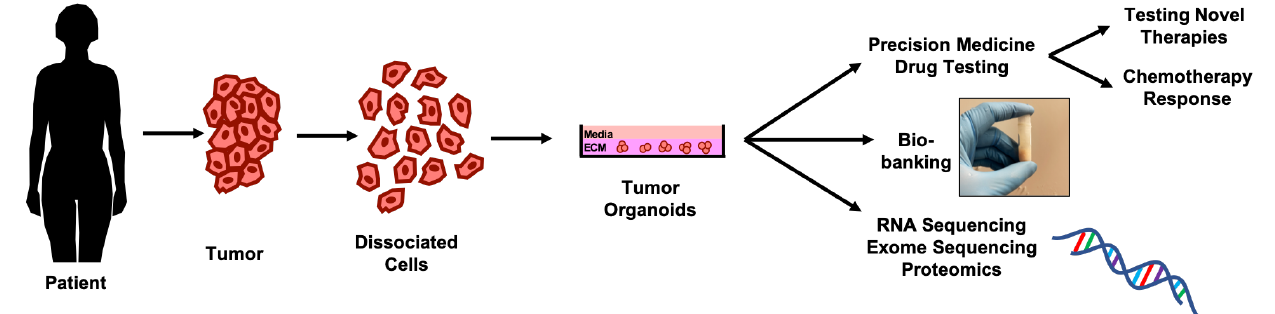
Figure 1. Overview of potential applications of tumor-derived organoids in ovarian cancer.